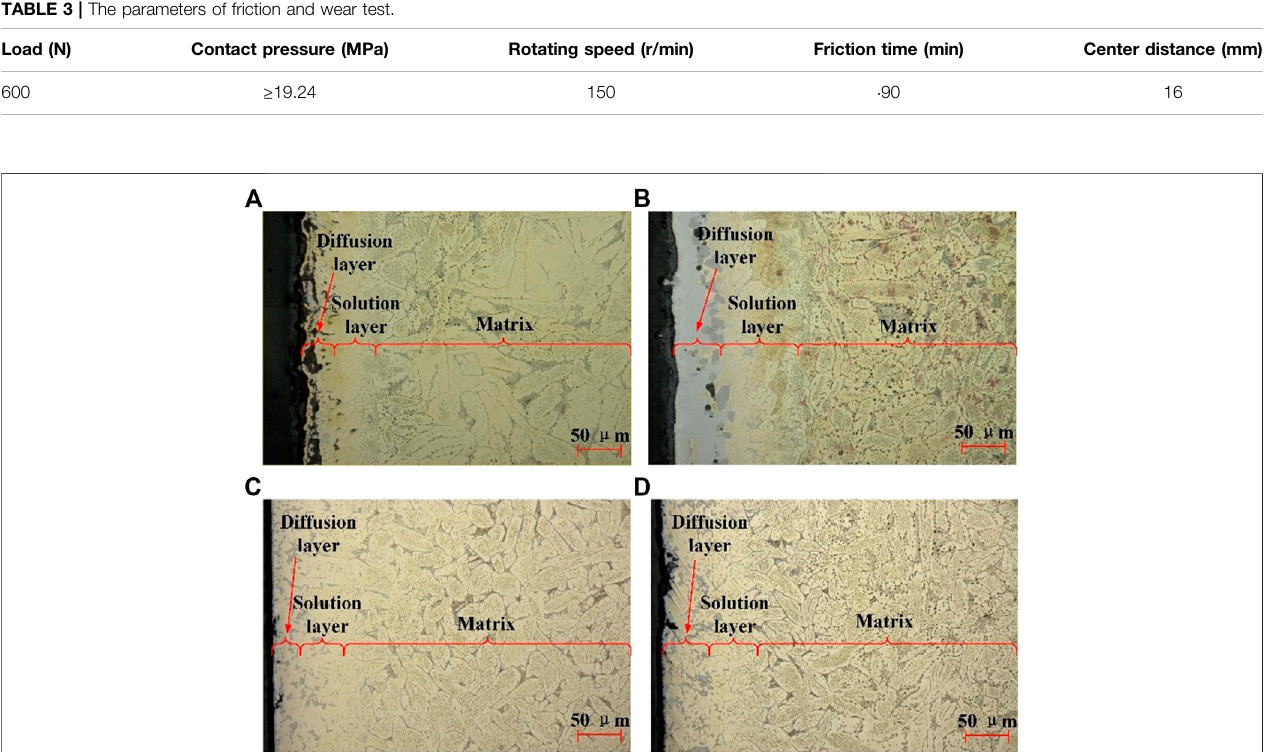
FIGURE 2 | Microstructure of the siliconized layer under the condition of different Si powder ratio. (A) 10%; (B) 30%; (C) 50%; (D) 70%.